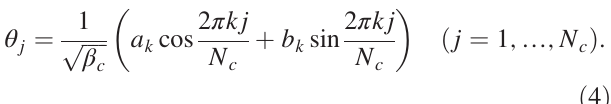
FIG. 2. Simulated harmonic six content of the horizontal COD showing the Fourier phase (top) and amplitude (middle) in the case where the closed orbit measurements are ideal (black circles) and where errors are included (red stars). Imperfect measure- ments are introduced by including BPM offsets ( σ ¼ 0 . 7 mm) and an additional statistical error ( σ ¼ 0 . 2 mm). The former is fixed for a given BPM, while the latter varies with every data point taken. The phase and amplitude for each Fourier component z is given by tan − 1 ½ Im ð z Þ = Re ð z Þ(cid:2) and j z j , respectively. Note that the Fourier amplitude is proportional to q 2 f k = ð q 2 − k 2 Þ . The lower figure shows the simulated horizontal (black) and vertical (blue) tunes with the triangles indicating the integers. The example assumes magnet misalignments with standard deviation 0.1 mm. These parameters were chosen to approximate those in the real